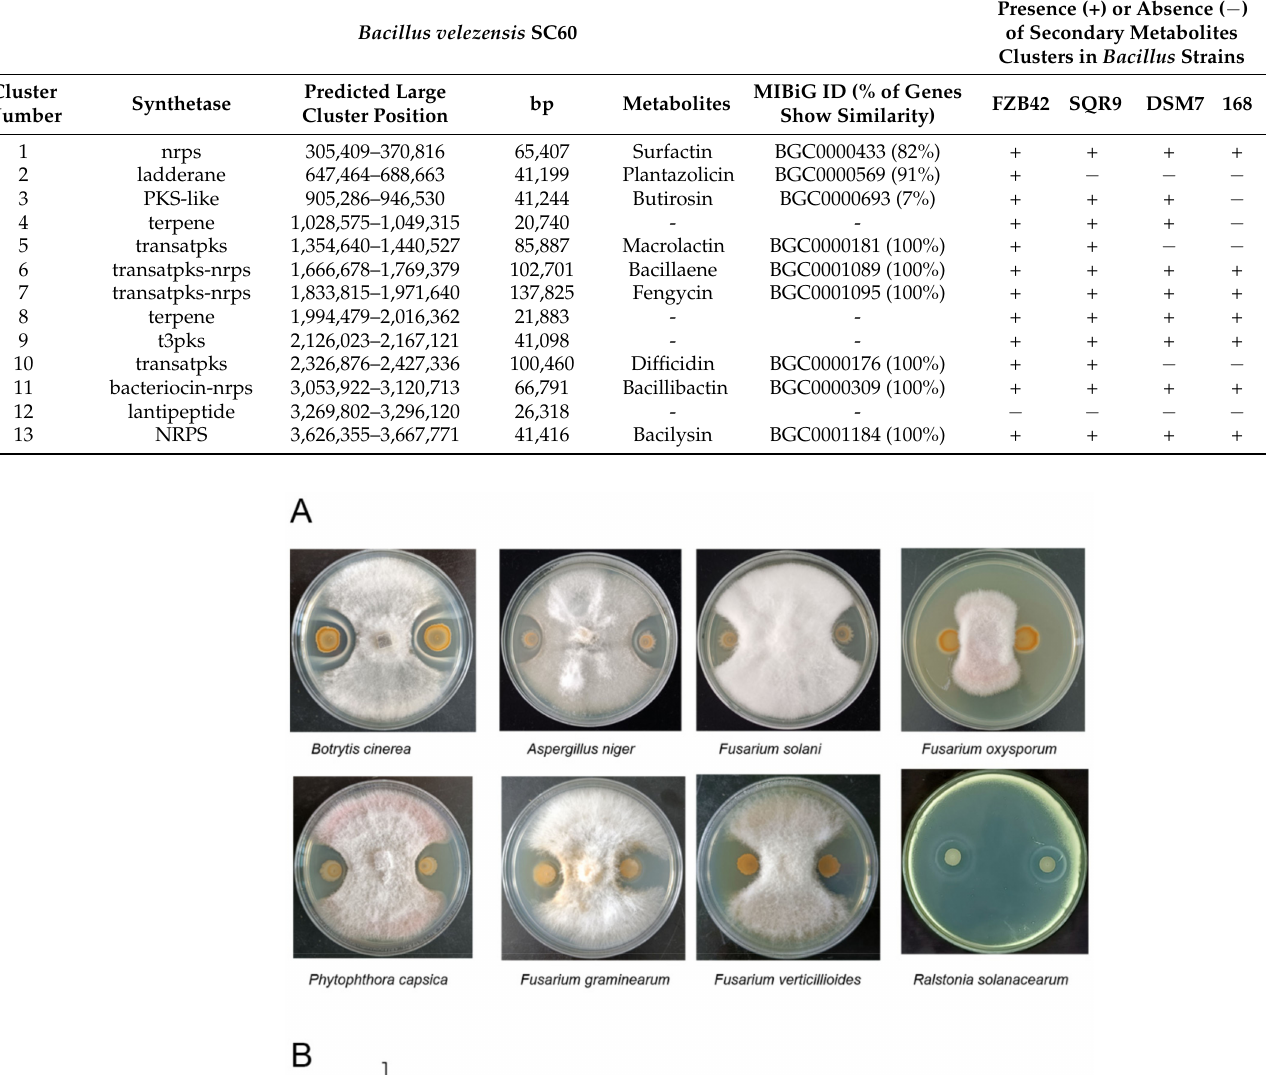
Table 4. Comparative analysis of secondary metabolite clusters of Bacillus velezensis SC60 identified in the genome with reference genomes.